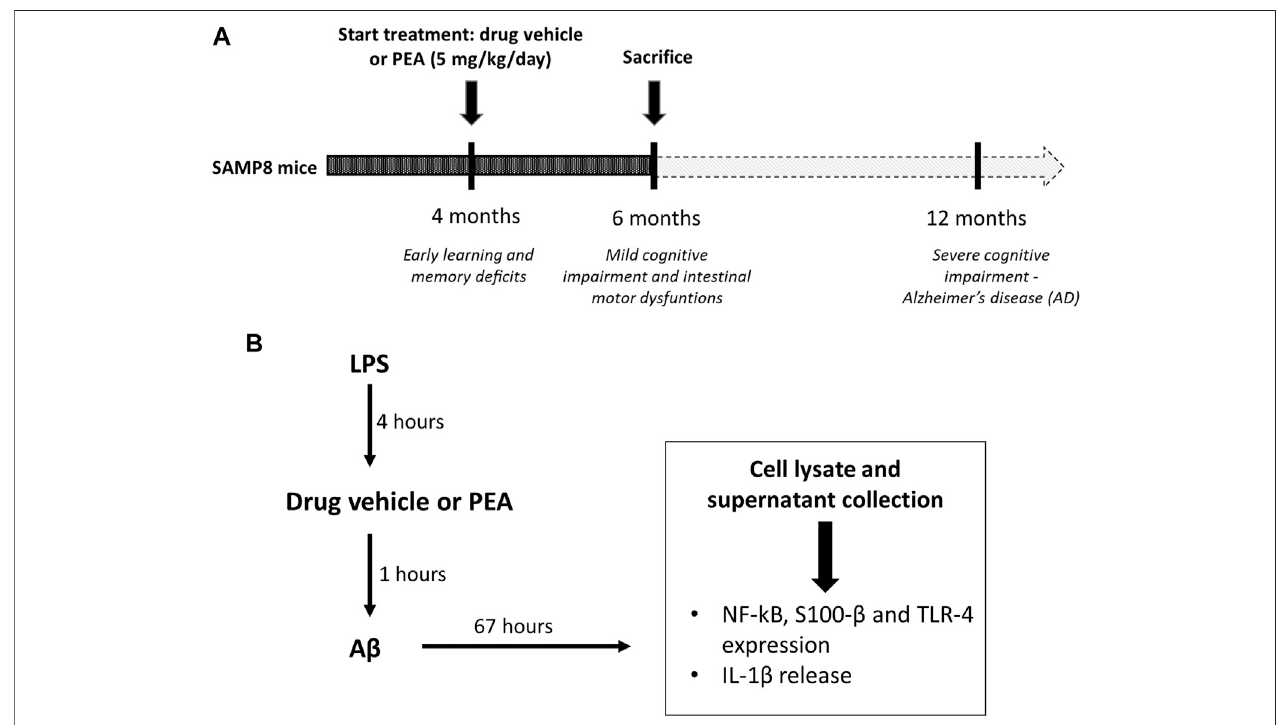
FIGURE 1 | Schematic representation of (A) in vivo treatment of SAMP8 mice with drug vehicle or PEA (5 mg/kg/day) for 2 months and (B) the design of experimentsonculturedEGCs:EGCsweretreatedfor4 hwithLPS(1 μ g/ml).Then,cellswereincubatedfor1 hwithPEAordrugvehiclebeforetheadditionofA β (1 μ M, 67 h). On the third day, cells were lysed for analysis of S100- β , NF- κ B p65 and TLR-4 expression and the culture media were collected for analysis of IL-1 β release. Abbreviations : A β , amyloid β 1-42; EGC, enteric glial cell; LPS, lipopolysaccharide; NF- κ B p65, nuclear factor- κ B p65; PEA, palmitoylethanolamide; S100- β , S100 Calcium Binding Protein B; TLR-4, Toll-like